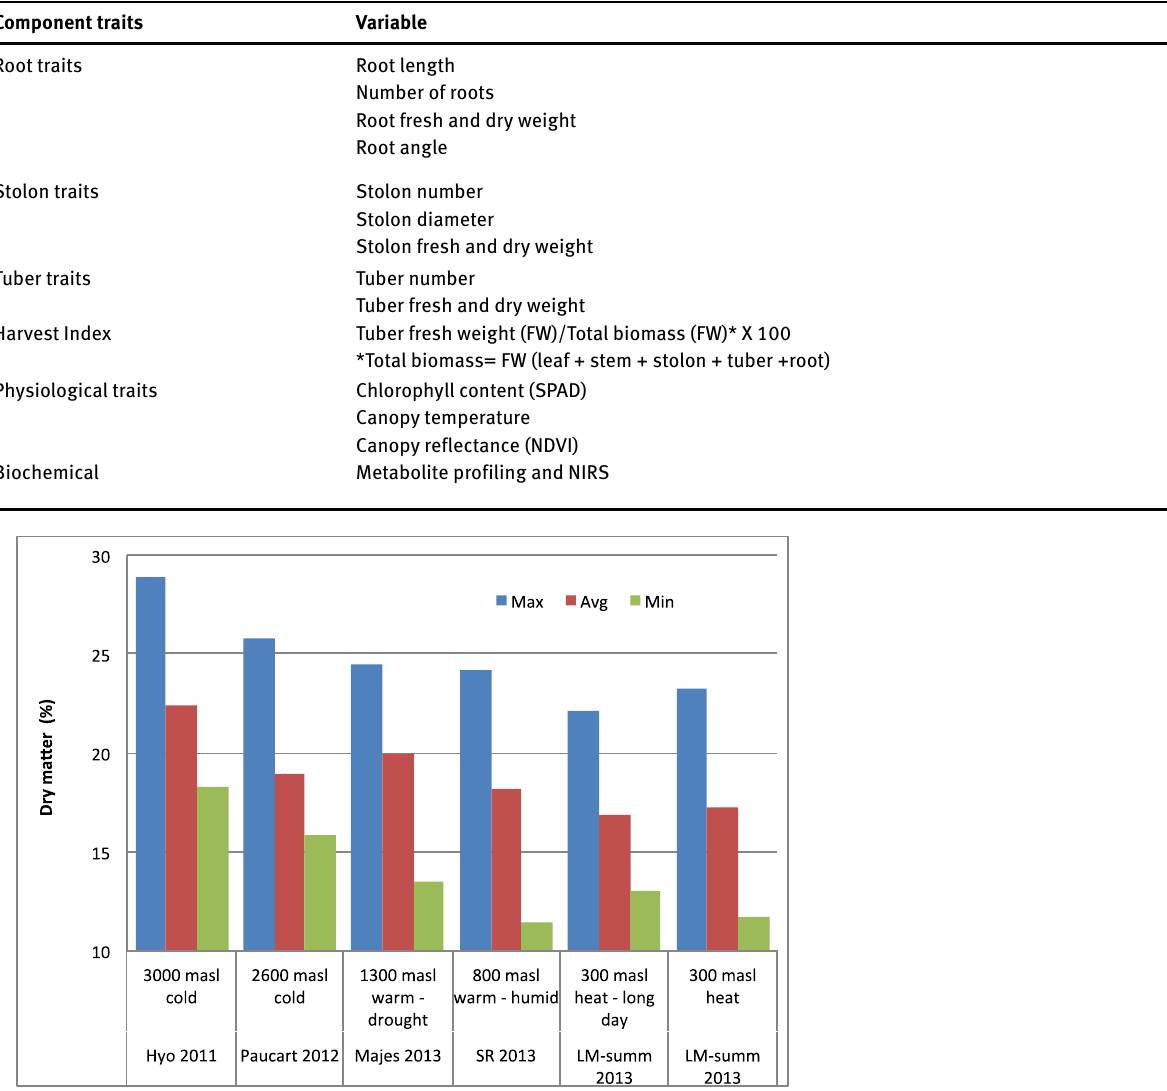
Figure 9: Effects of six temperature regimes on dry matter production of advanced lines of a potato LTVR population grown at five different altitudes in Peru (source: Bonierbale & Amoros 2016) Glycoalkaloid accumulation in tubers due to heat can lead to a bitter taste and food safety issues (M. Gastelo, pers. comm.). Consequently, in breeding for climate-smart crops quality components must be screened, and phenotyping protocols and molecular tools must be developed and used for these.